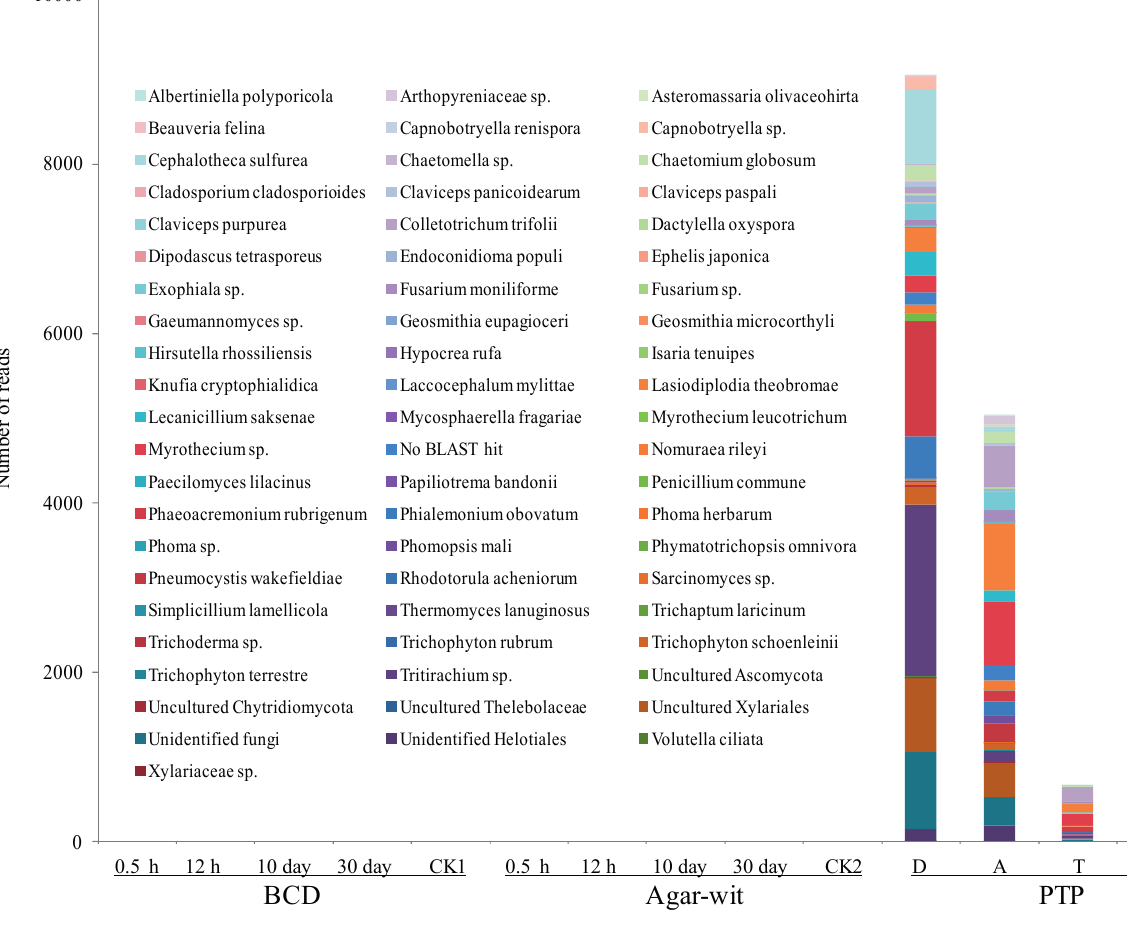
Figure 1. Distribution of fungal OUTs at the species level in the wounded wood induced by three different wounding methods, BCD, Agar-Wit and PTP. The wounded wood obtained by the partial-trunk-pruning (PTP) method was divided into four zones, i.e. , the decay (D), agarwood (A), transition (T), and white (W) zones. Samples obtained from the untreated healthy trees and the trees treated by the Agar-wit with ddH 2 O not inducer are referred to as CK1 and CK2,